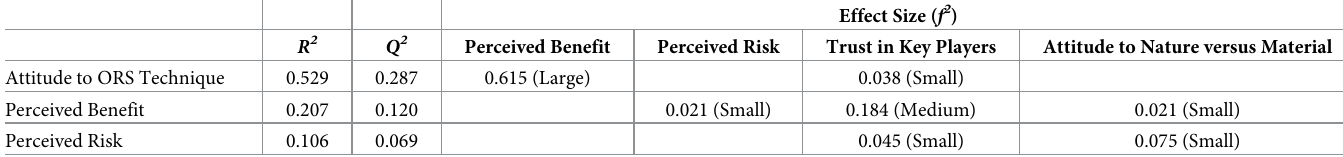
Table 6. Determination of Co-efficient ( R 2 ), Effect size ( f 2 ) and Predictive Relevance ( Q 2 ).